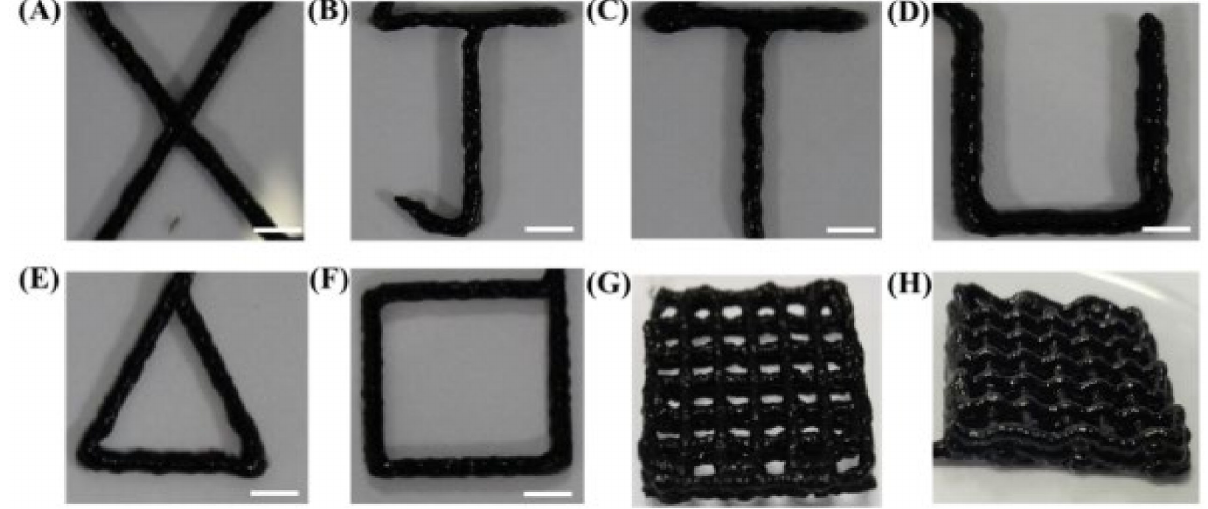
Figure 14. Three-dimensional printing behavior of different NIPAM/LAP/CNT BMIs ( A – H ) reported by Deng and co-authors. Adapted with permission from [7], American Chemical Society,